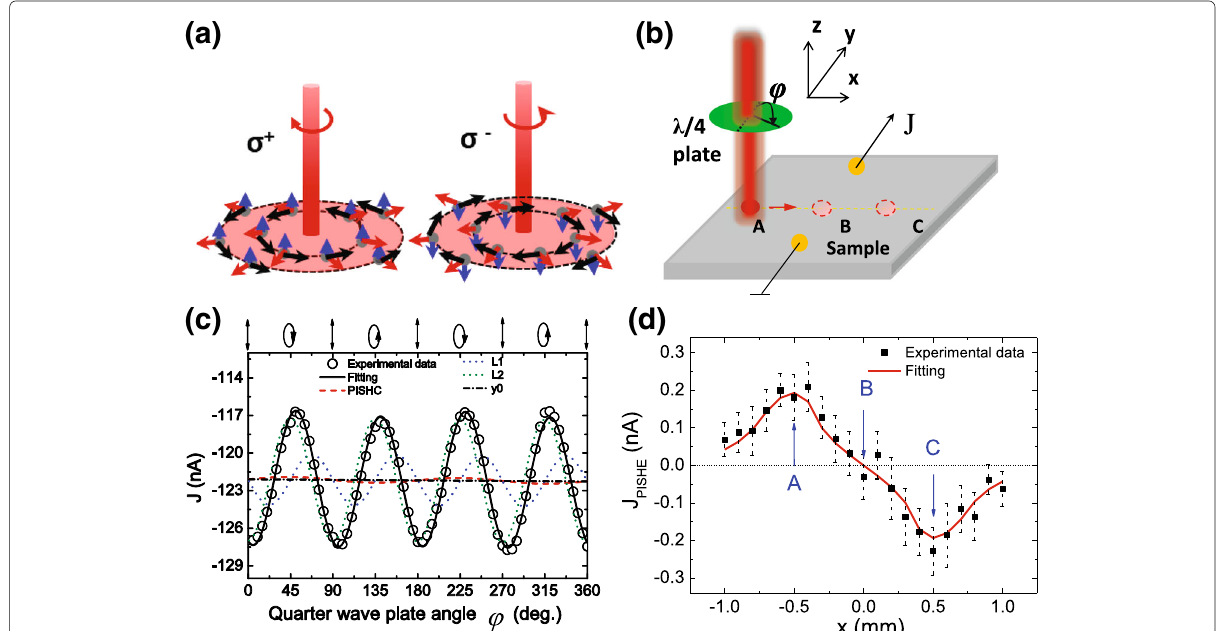
Fig. 1 Method to obtain the PISHE current and the PISHE measured at 300 K. a Illustration of the movement of spin polarized electrons under the normal illumination of left-hand circular polarization ( σ + ) or right-hand circular polarization ( σ − ) light. The red arrows denote the flowing of electrons, the blue arrows indicate the spin direction of electrons, and the black arrows show the spin transverse force acting on electrons. b The geometry used to measure the PISHE current. c The photocurrent measured at 300 K as a function of the phase angle ϕ under normal incidence when the light spot is illustrated at point A. The solid line (black) is the fitting curve using Eq. (1), the dashed line (red) represents the PISHE current, and the blue and green dotted lines represent the L 1 and L 2 component. The dashed-dot line indicates the background current J 1 . d The PISHE current as a function of light spot locations measured at 300